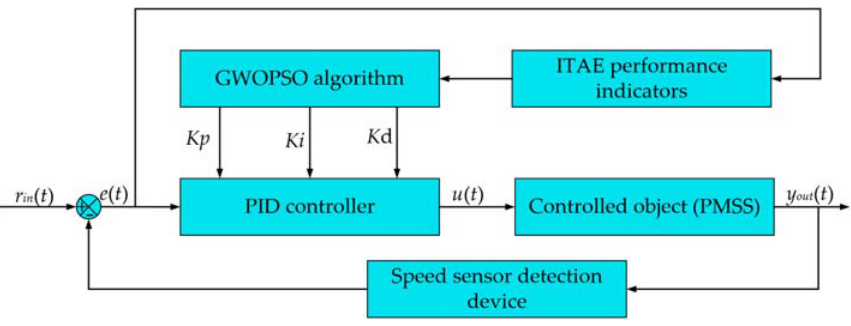
Figure 5. GWO − PSOPID control schematic diagram. Figure 5. GWO-PSOPID control schematic